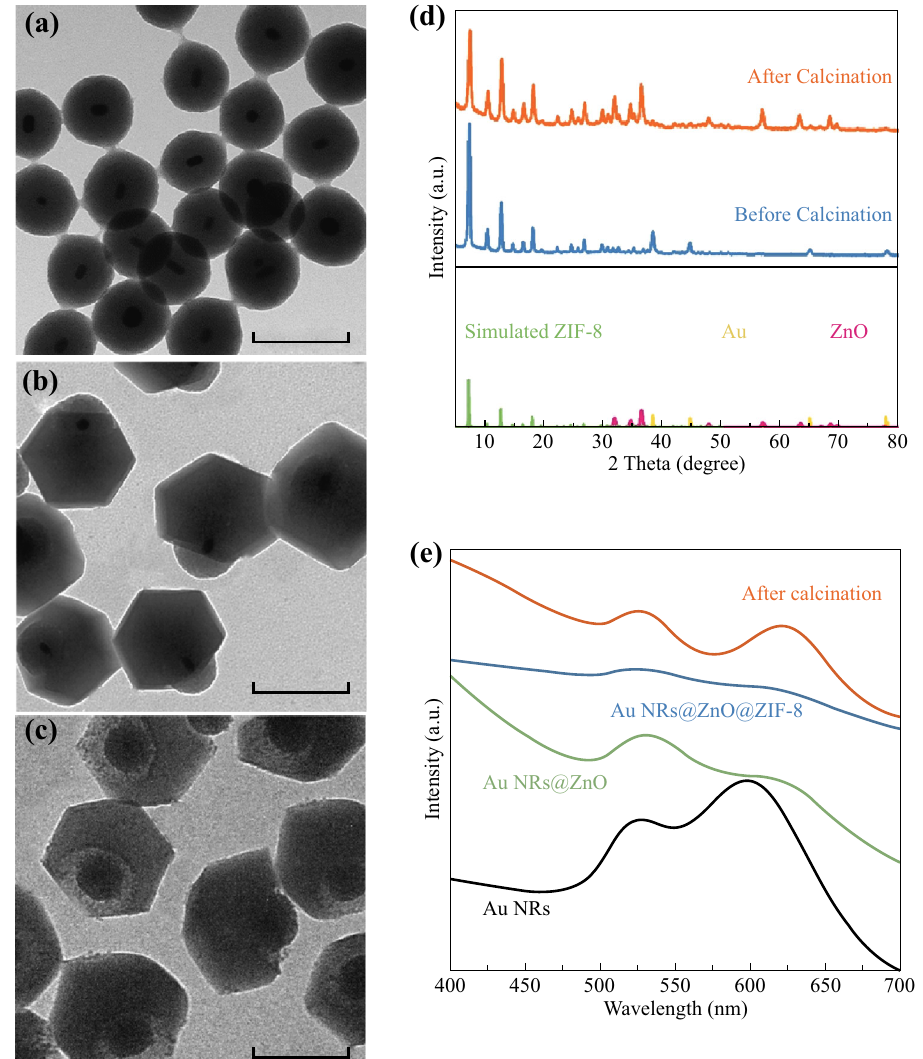
Fig. 2 TEM images of a Au@ZnO core/shell NPs, b Au@ZnO@ZIF-8 NPs before and c after calcination; d XRD patterns of b and c ; e UV–Vis absorption spectra of samples in a , b , c , and pristine Au NRs. Scale bars in a , b, and c represent 250, 400, and 400 nm,